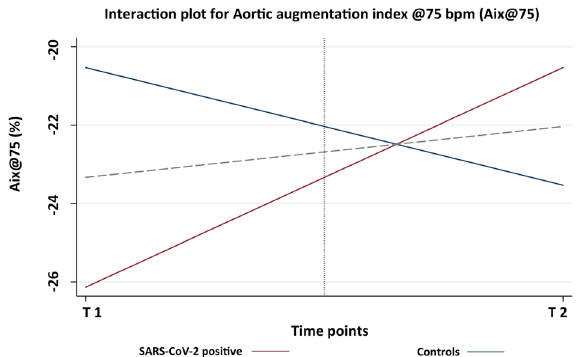
Figure 1. Aortic augmentation index @75 bpm at the two time points according to SARS-CoV-2 status and graphical depiction of the two-way repeated measures